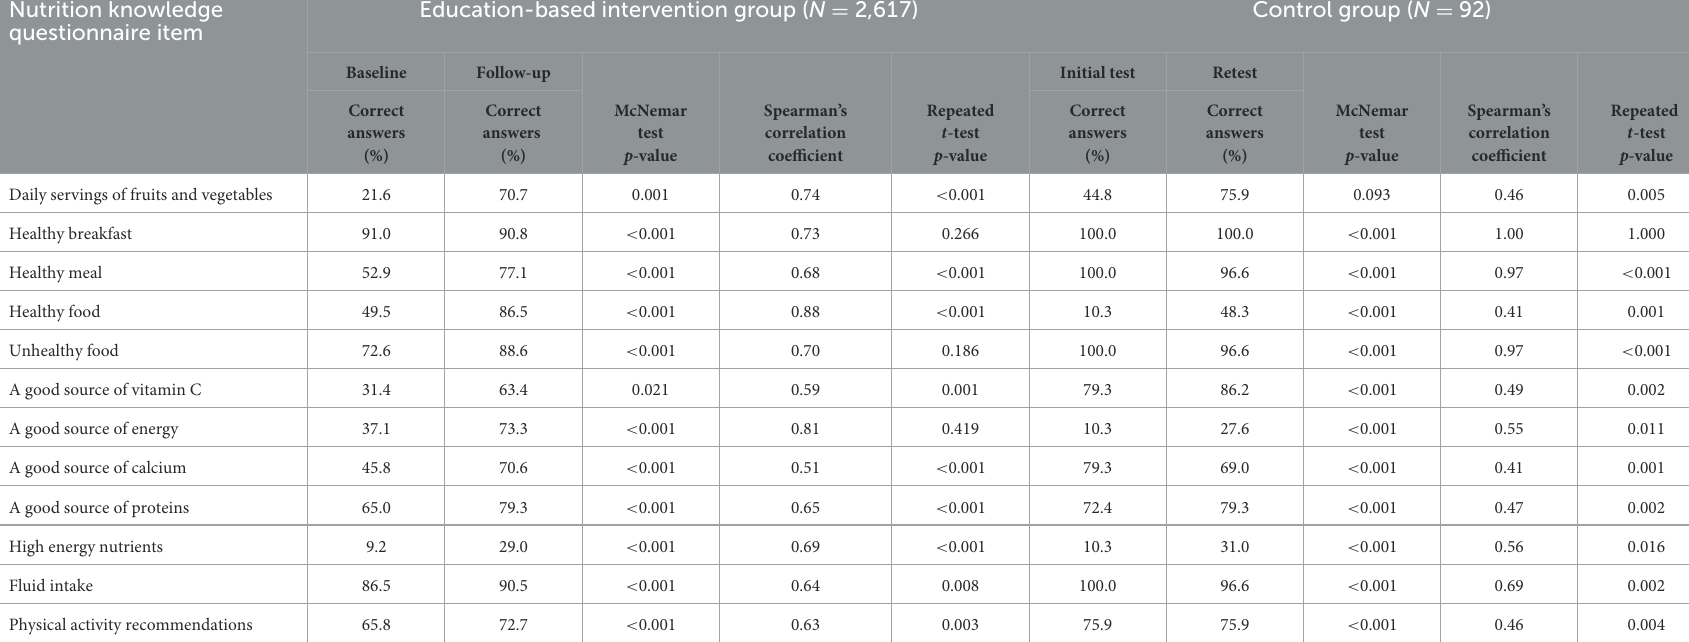
TABLE 4 Comparison of nutrition knowledge between education-based intervention group and control group and test–retest comparison of nutrition knowledge scores for the reliability of nutrition knowledge